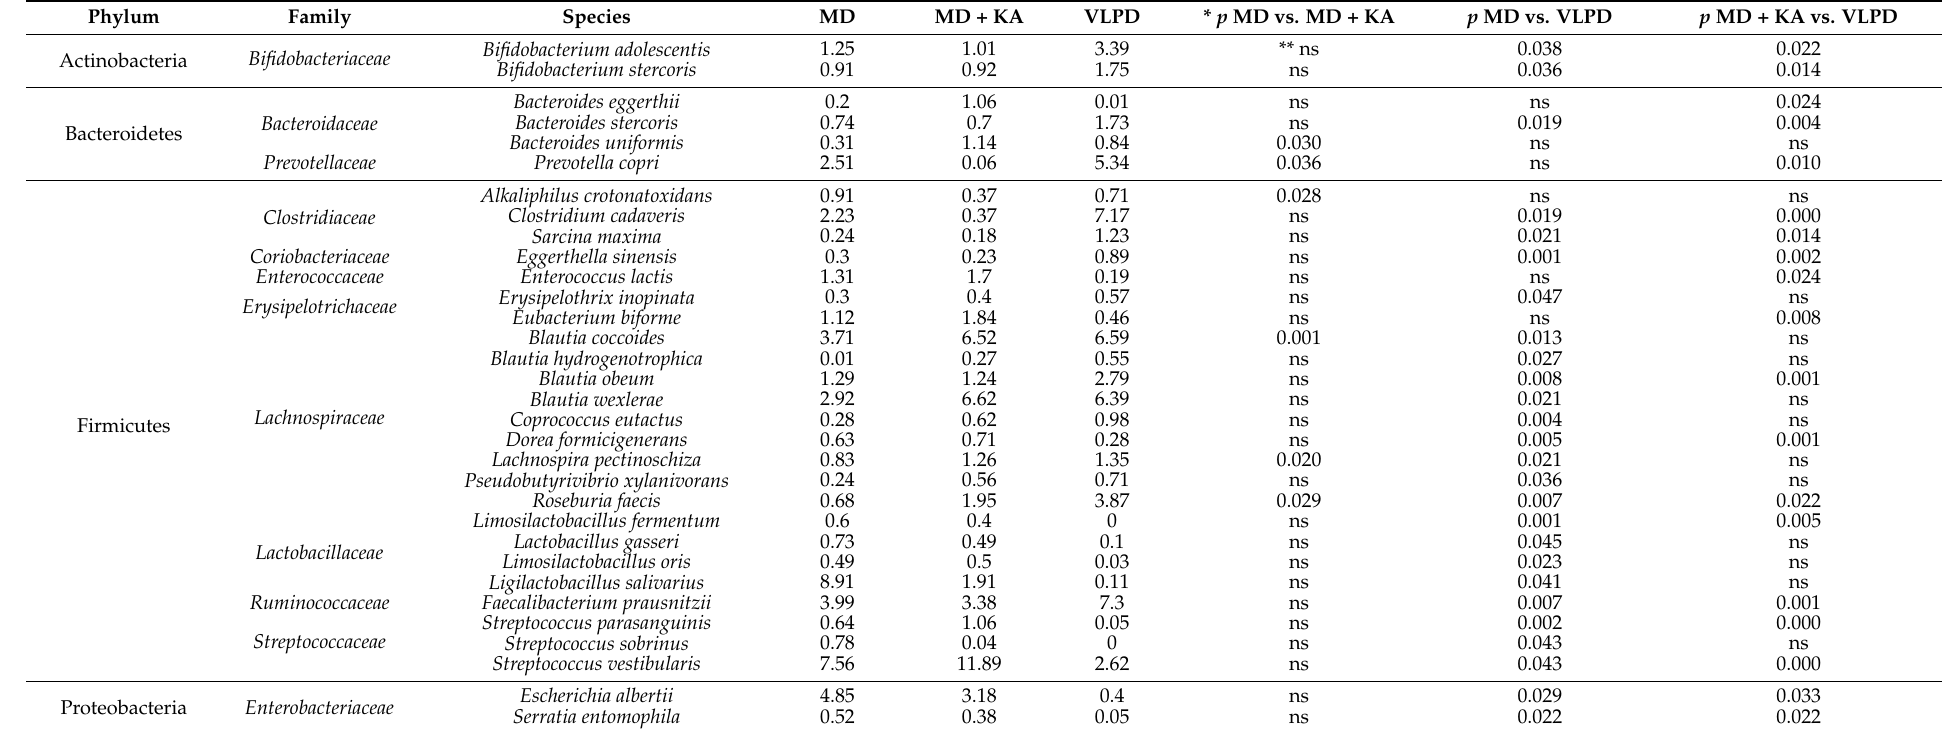
Table 3. Dietary changes in gut microbiota composition of patients with chronic kidney disease (CKD). Significant ( p < 0.05) bacterial species with a mean of relative abundance (16S rRNA gene amplicon) >0.5% at least in one dietary arm found in feces of CKD patients after three different dietary regimens: the Mediterranean diet (MD), the ketoanalog-supplemented Mediterranean (MD + KA), and the ketoanalog-supplemented very-low-protein diet (VLPD).